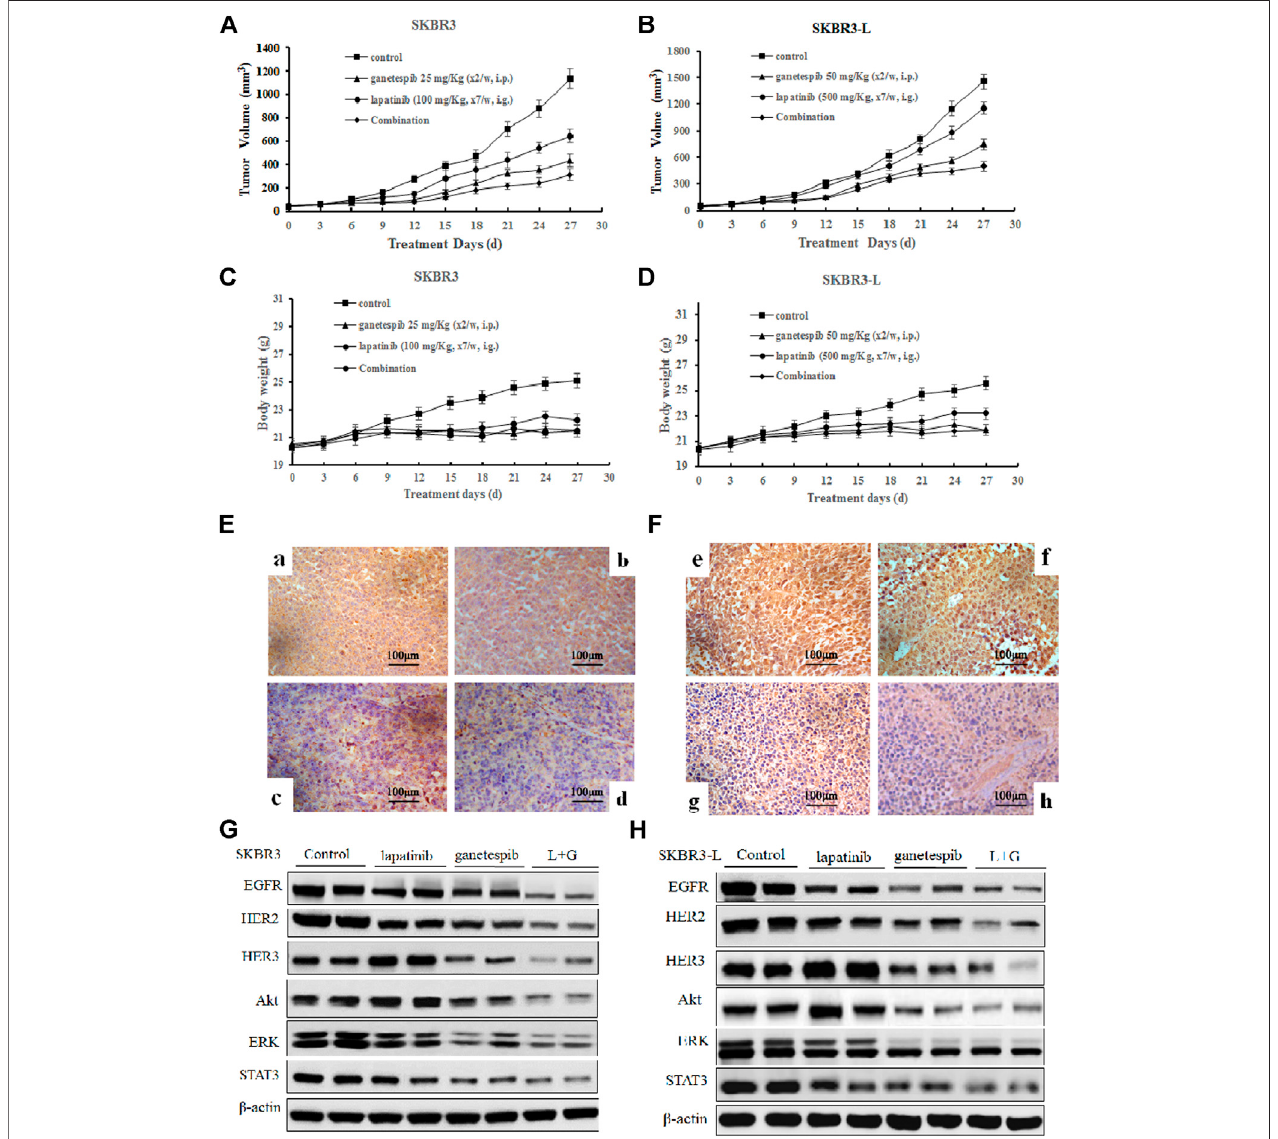
FIGURE 5 | Antitumor activity of ganetespib and lapatinib, alone or in combination, in xenograft models in vivo . (A) and (B) Bearing tumors with volumes of approximately 50 mm3, SKBR3 and SKBR3-L tumor xenograft nude mice were randomized into treatment groups (n (cid:2) 6/group) and received vehicle, lapatinib, ganetespib or combination (in a vehicle of 1% DMSO, 30% polyethylene glycol and 1% Tween 80) for 4 weeks. Data are presented as means ± SD (n (cid:2) 6, p < 0.05). (C) and (D) Mousebodyweightwasmeasured everythreedays.HER2expressionin (E) SKBR3and (F) SKBR3-L tumorswasdeterminedbyimmunohistochemistry. Pictures a and e show vehicle controls; pictures b and f, c and g, d and h show lapatinib-, ganetespib-, and combination-treated groups for the SKBR3 and SKBR3-L xenografts, respectively. Tumor tissues excised from (G) SKBR3 and (H) SKBR3-L xenografts were lyzed, and changes in the levels of EGFR, HER2, HER3, Akt, ERK, and STAT3 protein were assessed by western